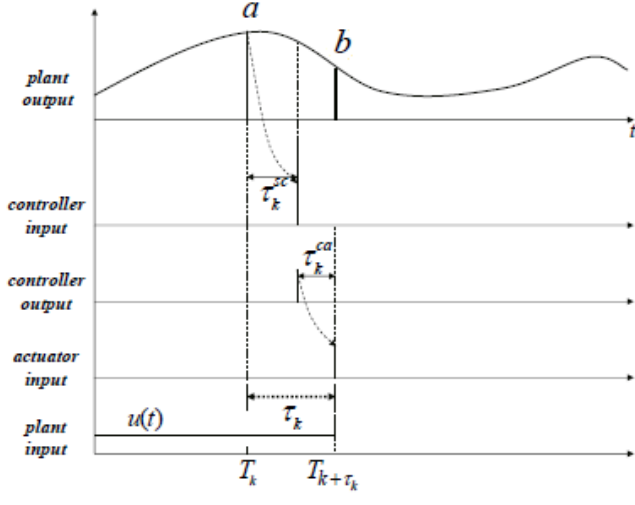
Figure 2. Network delay propagation timing